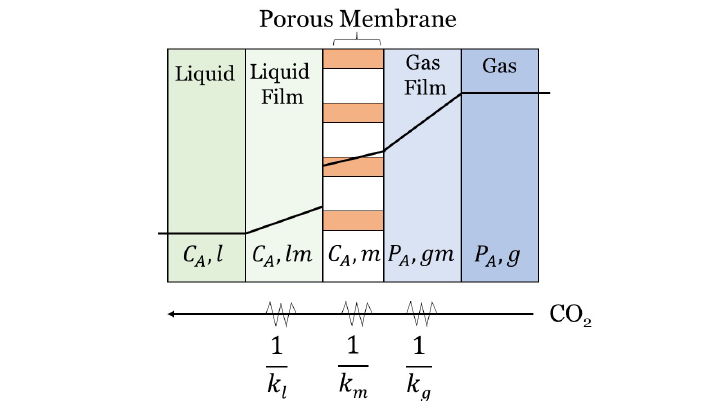
Figure 3. A resistance-in-series (RIS) illustration for CO 2 crossing a membrane in a HFMC. There are mass transfer resistances associated with the gas phase, the membrane, and the liquid phase. Each resistance can be expressed as the inverse of the mass transfer coefficient for that phase. The layers included to accomplish this analysis are the gas, gas film, membrane, liquid film, and